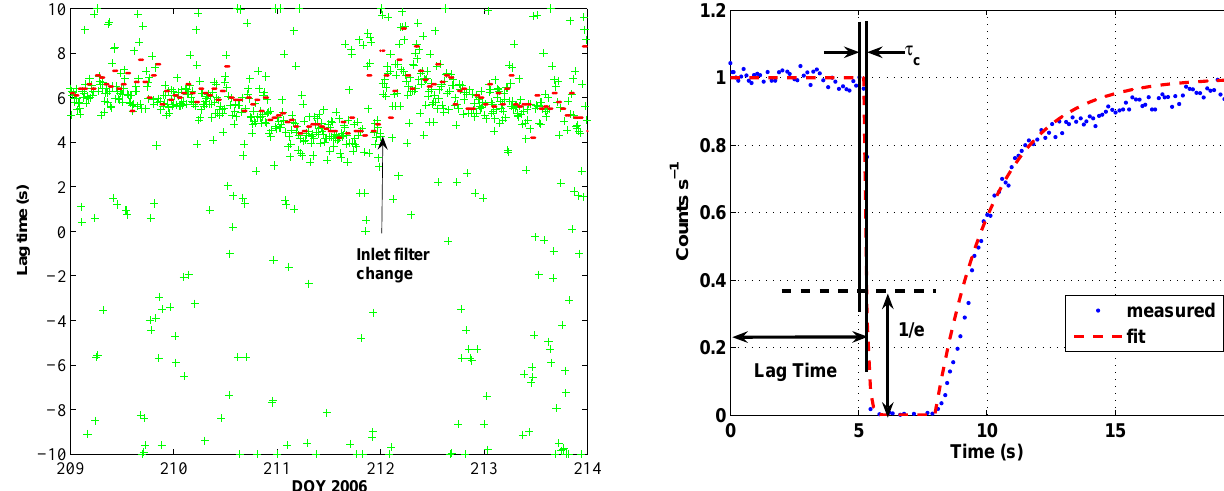
Fig. 5. Lag time results from the cross-correlation calculation for DOY 209–214 during TexAQS-2006. The crosses represent results for 10-min data analyses, and the dots show the hourly mean data of 10-min results that fell between 4 and 10s.